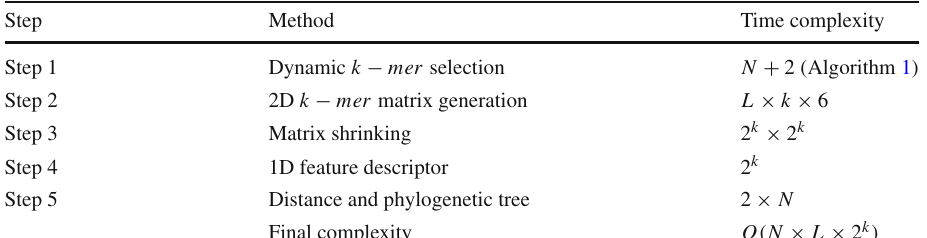
Table 11 Time complexity and memory space consumption comparison with existing works